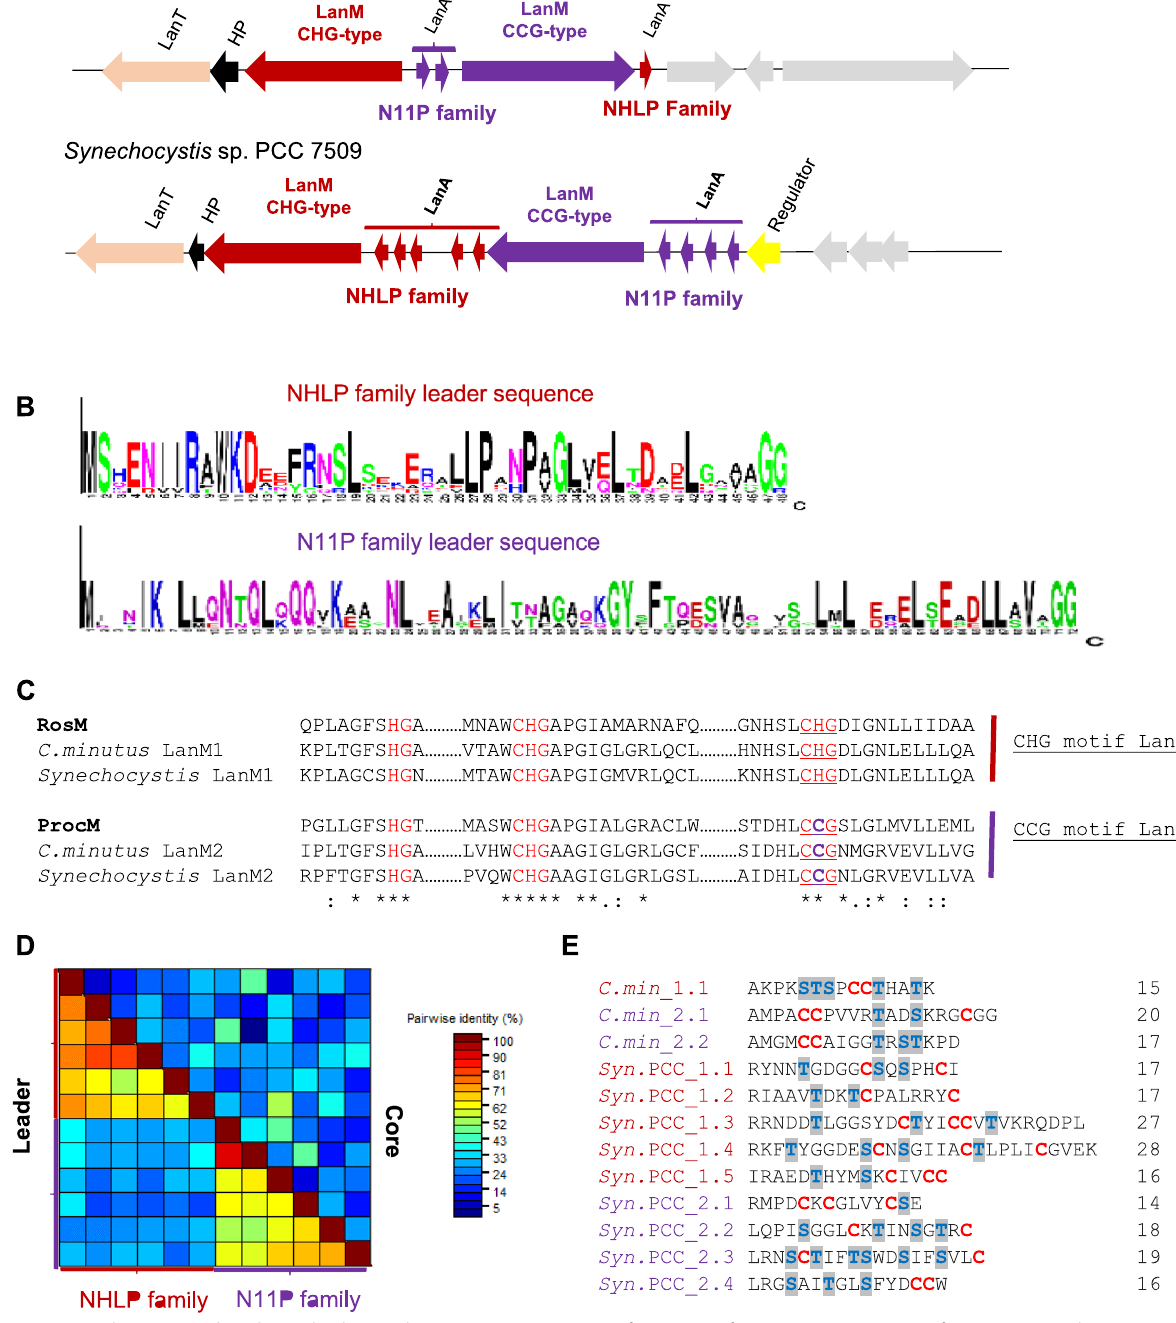
Fig. 4 Novel BGCs, encoding diverse lanthipeptide core sequences, consist of two LanMs for processing two types of precursor peptides. A Two BGCs encoding NHLP and N11P family lanthipeptide leaders in their precursor peptides with the corresponding synthetases, i.e. CHG motif and CCG motif LanM, were identified in Synechococcales . B Sequence logos of NHLP family and N11P family lanthipeptide leader sequences using the precursor sequences from the above two BGCs. C Sequence alignment of cyclase domain of putative LanMs from characteristic BGC of Synechococcales showed a difference in catalytic motif. RosM like LanMs has a CHG motif, while ProcM like LanMs have a CCG motif. D Sequence identity percentage in the pairwise alignment of the 12 lanthipeptide precursors’ leader sequences (lower half) and core sequences (upper half). Diversity among lanthipeptide core sequences was high, irrespective of leader conservation. E Multiple sequence alignment of lanthipeptide core sequences depicts natural diversity. LanA precursor peptide, LanM modification enzyme, HP Hypothetical Protein, LanT dual function peptidase-domain containing